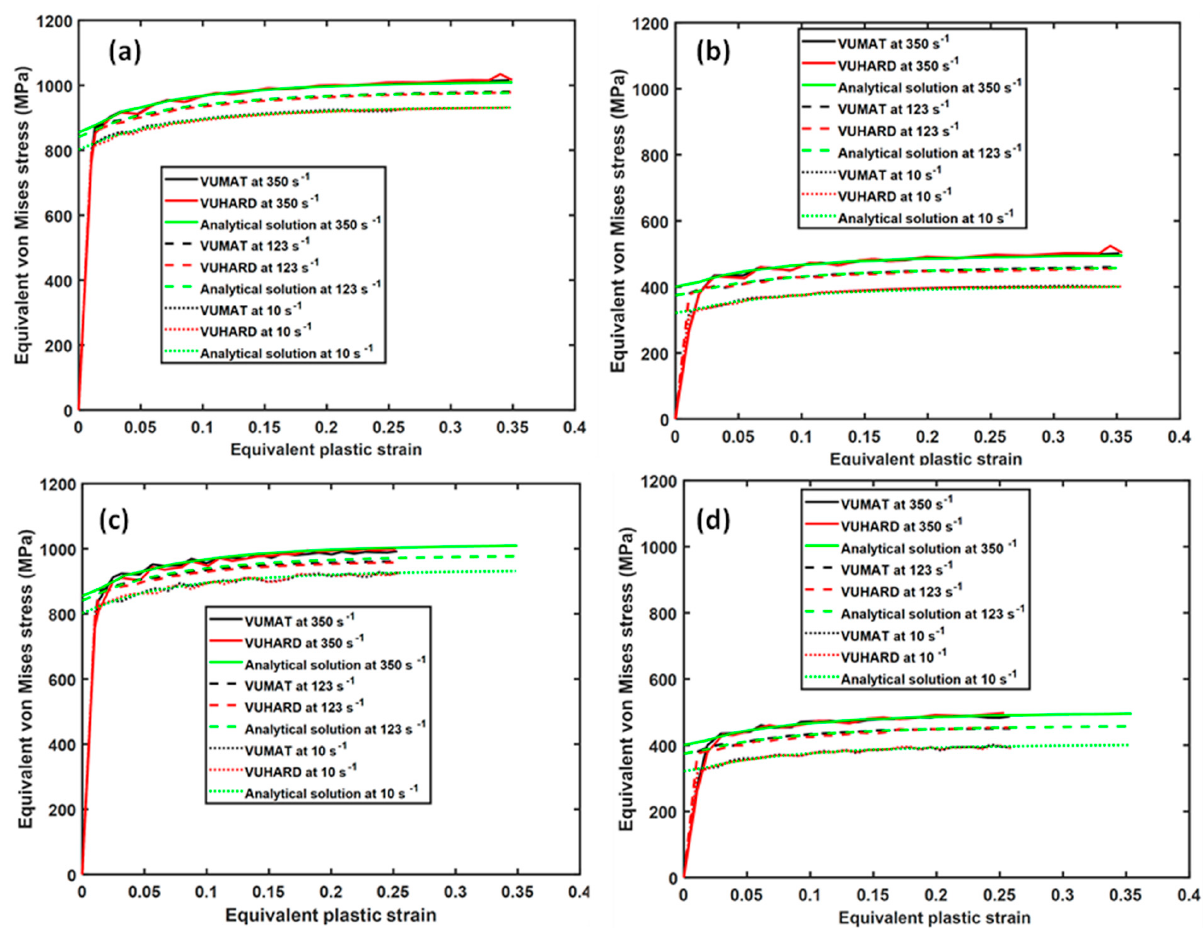
Figure 9. Comparison between the analytical and numerical solutions in VUMAT and VUHARD at three different test velocities and temperatures of ( a,c ) 298 K and ( b , d ) 773 K for an 8-node linear brick element in ( a,b ) compression and ( c , d ) tension for samples C.